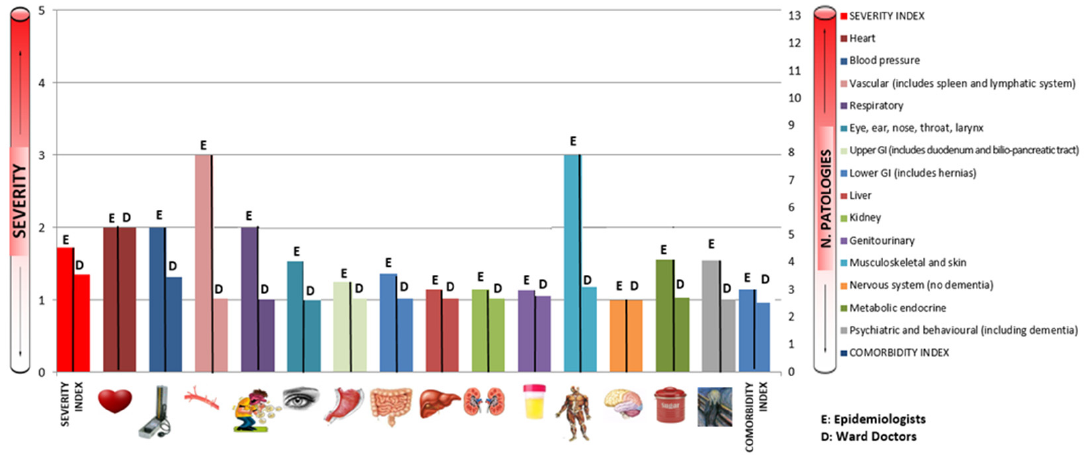
Figure 2. Sample divided for control and age.